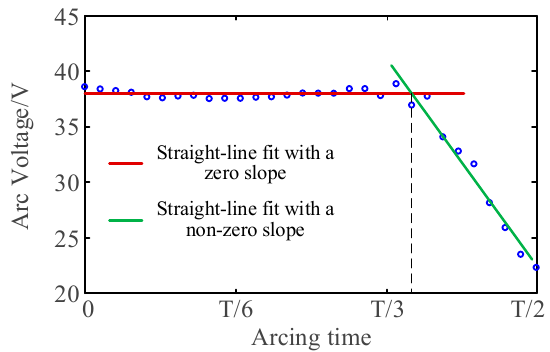
Figure 2. The average value of arc voltage at different AST. After curve fitting, it can be obtained that u 0 = 22 V, u D = 38 V, t D = 0.36 T.